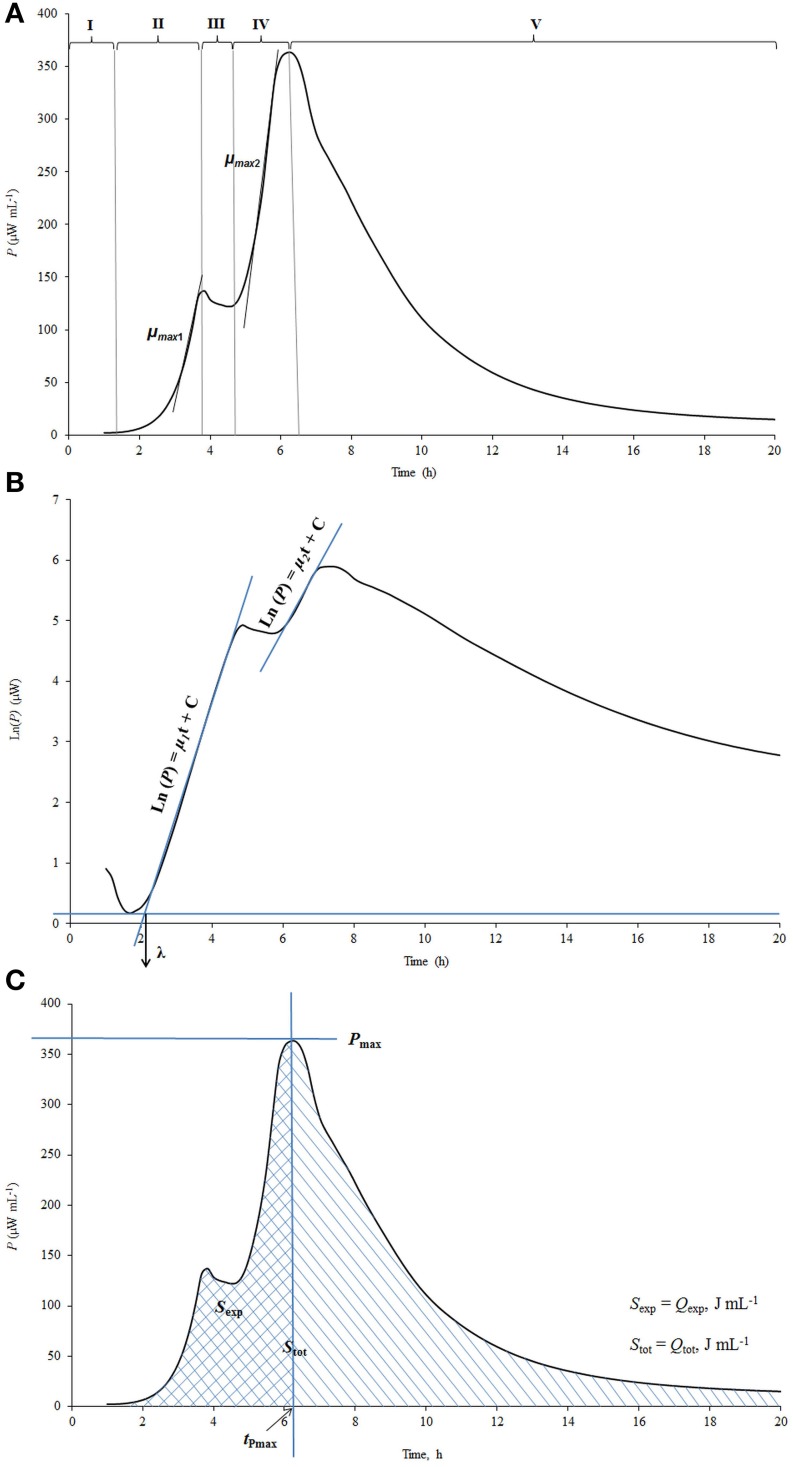
The explanation of the processing of calorimetric power-time curves. (A) The division of calorimetric power-time curves into five phases; (B) Determination of the maximal calorimetric growth rates during the first (μmax1, Wh−1) and the second exponential phase (μmax2, Wh−1), and the duration of the lag-phase (λ, h); (C) Determination of the heat evolution during combined exponential phases (Qexp), and during the growth of the cultures (Qtot).